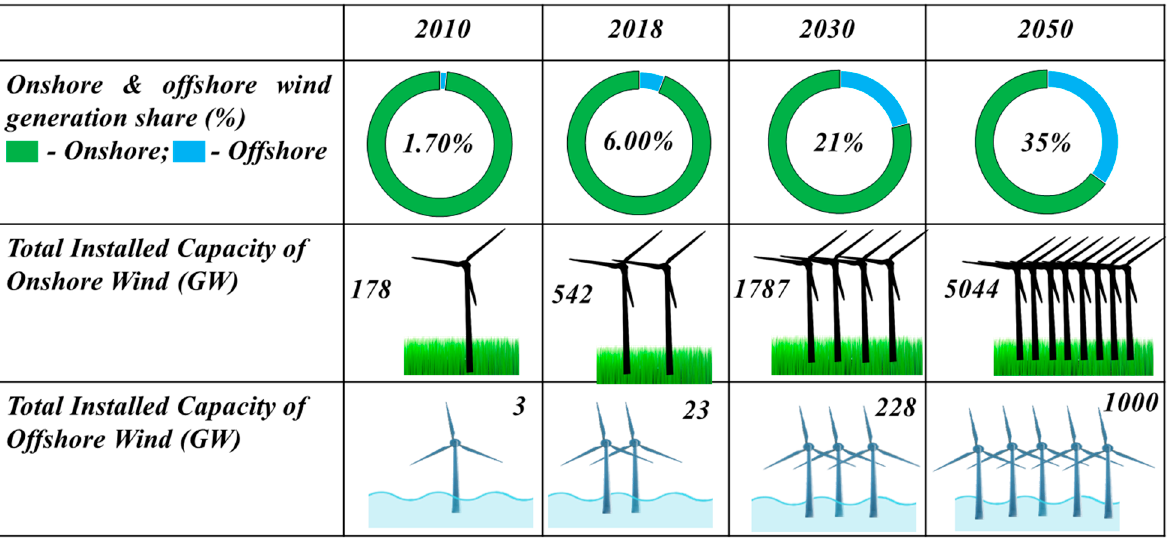
Figure 1. Growth and prediction of wind generation share over 40 years.